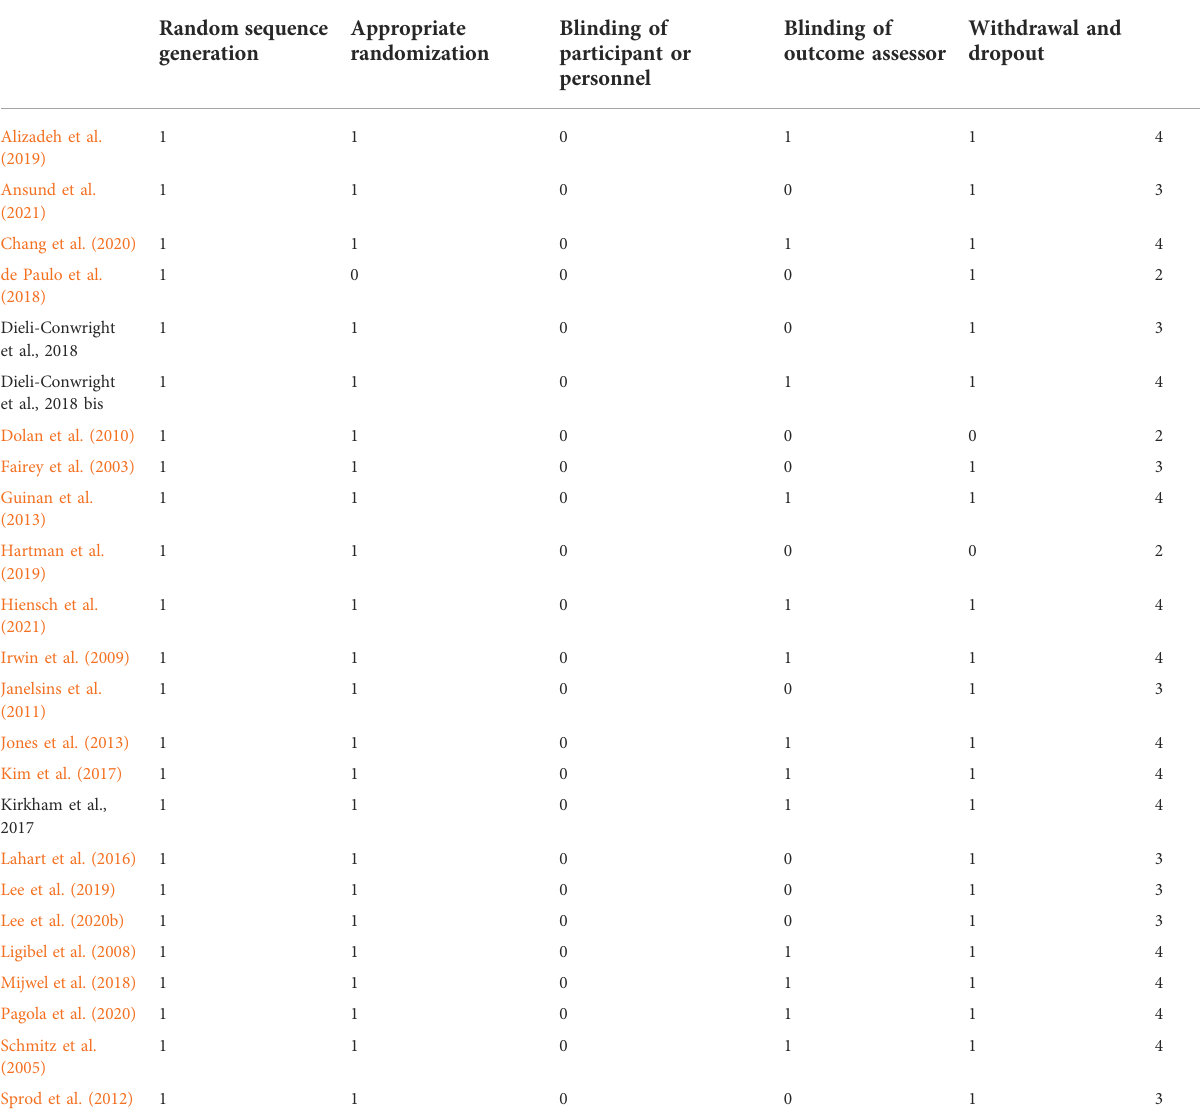
TABLE 1 Quality assessment of the studies included in the present systematic